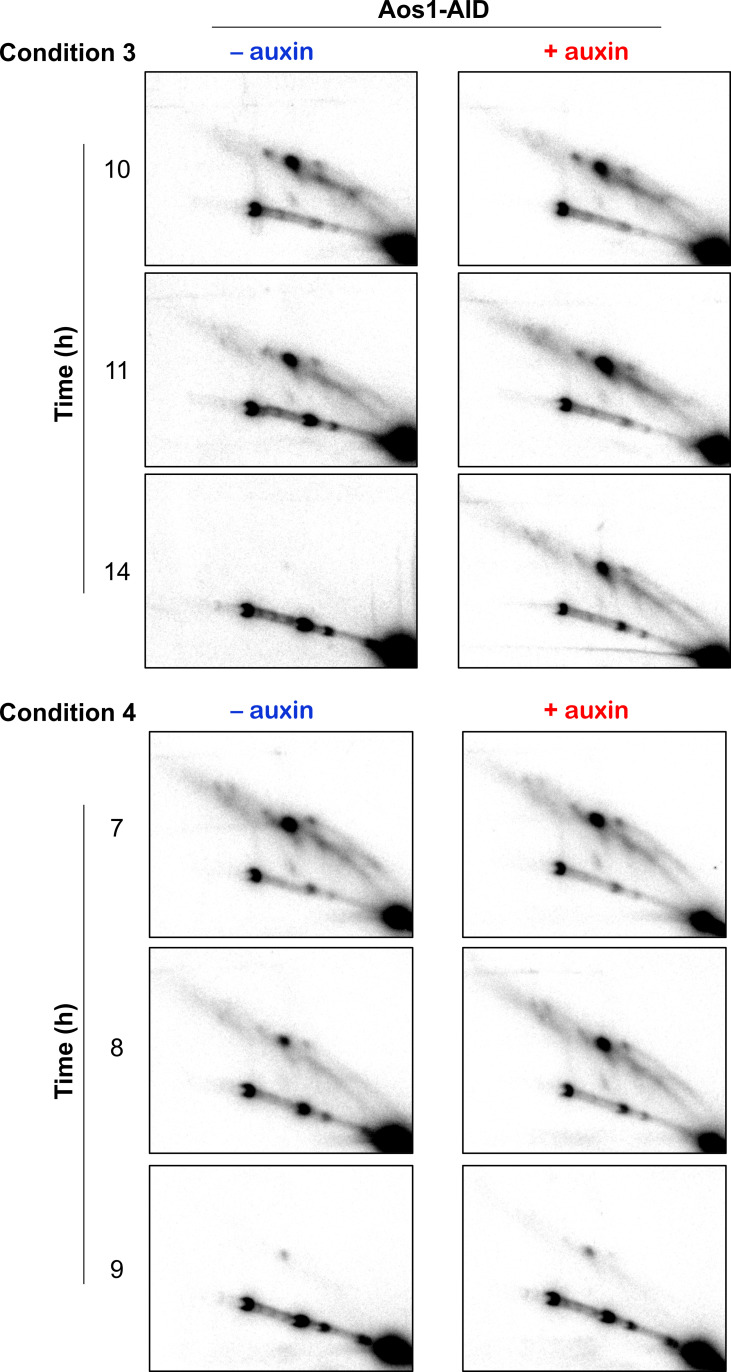
Analysis of meiotic recombination and synapsis.(A–E) Physical assay system for monitoring recombination at the HIS4::LEU2 locus. (A) Map of the locus showing diagnostic restriction sites, hybridization probe, detectable DNA species and their molecular weights. X, XhoI site; B, BamHI site; N, NgoMIV site; DSB, double-strand break; IH-dHJ, interhomolog double-Holliday junction; IS-JM, inter-sister joint molecule (likely IS-dHJ); mc-JM, multi-chromatid joint molecule; SEI, single-end invasion. (B) Southern blot image of 1D gel analysis of DSBs and crossovers. (C) Inferred structures of SEI and dHJ intermediates. (D) Southern blot image of native/native 2D gel analysis of recombination intermediates. (E) 1D Southern blot image of 1D gel crossover/non-crossover analysis. (F) Representative immunofluorescence images of Zip1 immunostained nuclear spreads illustrating the different classes of Zip1 staining scored in Figure 3 and Figure 3—figure supplement 2.